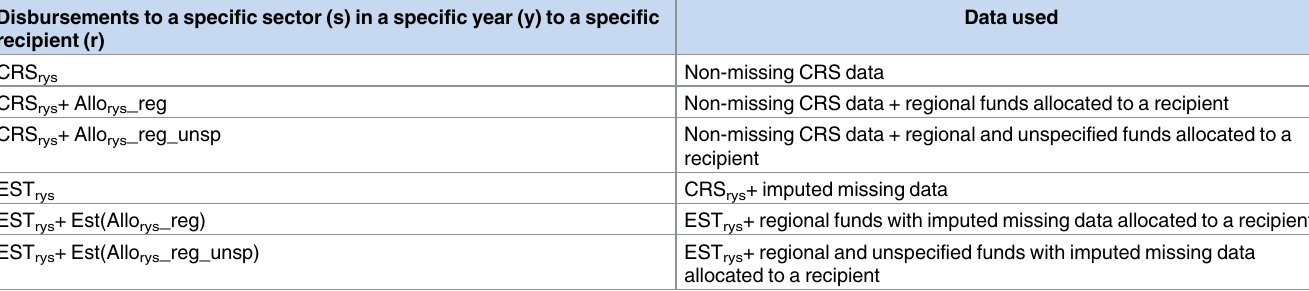
Table 2. Six sets of annual recipient-level